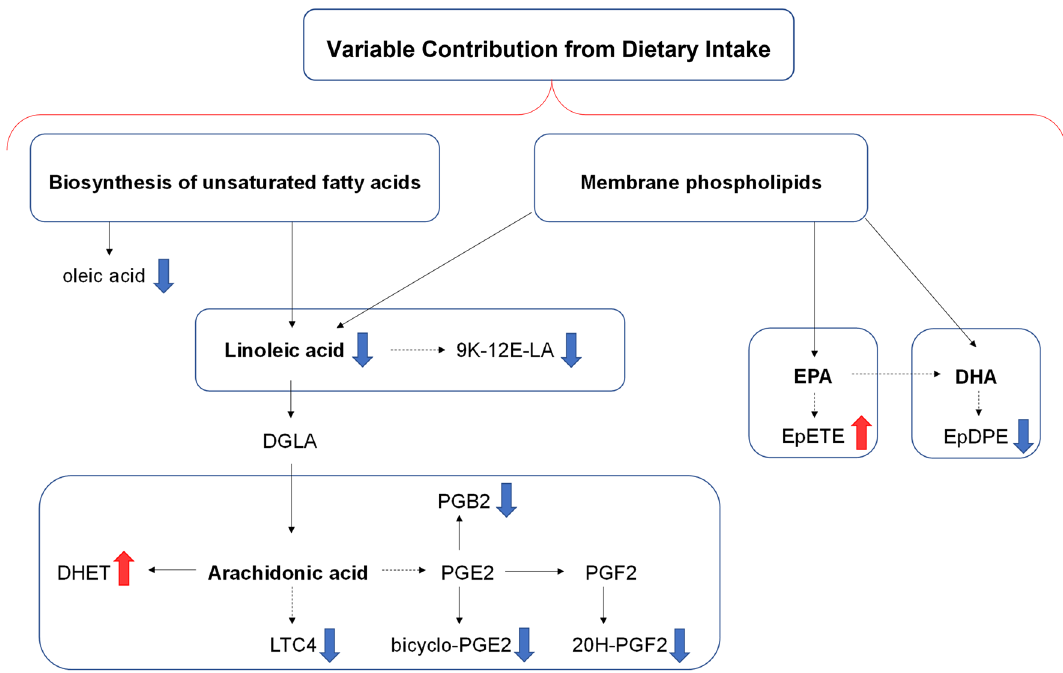
Figure 5. Simplified KEGG maps of the top 10 differentially expressed oxylipins and fatty acids in CF patients. Blue and red arrows mean down-regulated and up-regulated, respectively. 9 K-12E-LA: 9 keto-12 epoxy-octadecenoic acid; DGLA: dihomo-γ-linolenic acid; DHA: docosahexaenoic acid; DHET: dihydroxy- eicosatrienoic acids; EPA: eicosapentaenoic acid; EpDPE: epoxy-docosapentanoic acid; EpETE: epoxy- eicosatetraenoic acids; LTC4: leukotriene C4; PGB2: prostaglandin B2; PGE2: prostaglandin E2; PGF2: prostaglandin